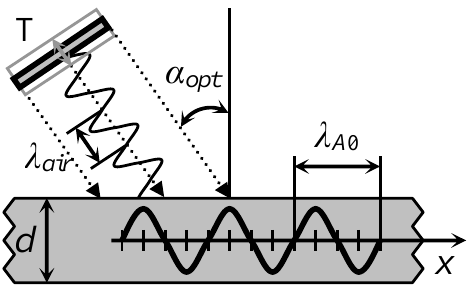
Figure 1. Principle of air-coupled Lamb wave excitation according to the Snell’s law. The value of the optimum incidence angle α opt according to the Snell’s law (Equation (2)) depends on the ratio of the phase velocities c air / c A 0 ( f ). For the case when the ultrasound phase velocity in the structure is greater or equal than the sound velocity in air c A 0 ( f ) ≥ c air , the optimum incidence angle α opt calculated according to Equation (2) is presented in Figure 2.